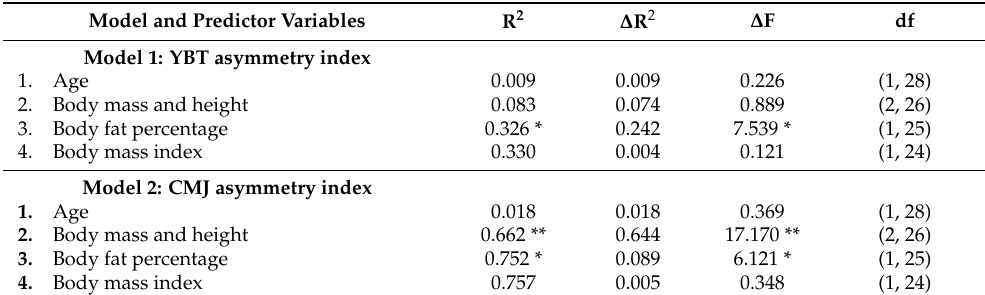
Table 2. Summary of hierarchical regression analysis to determine predictor variables for asymmetry indices of YBT and